Question: Name the type of graph shown.
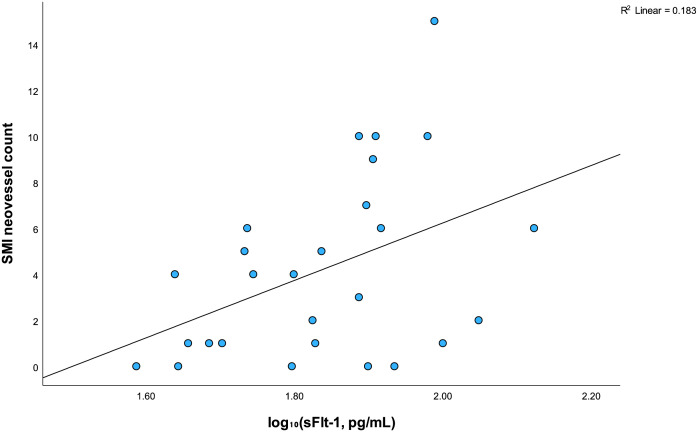
Answer: scatter